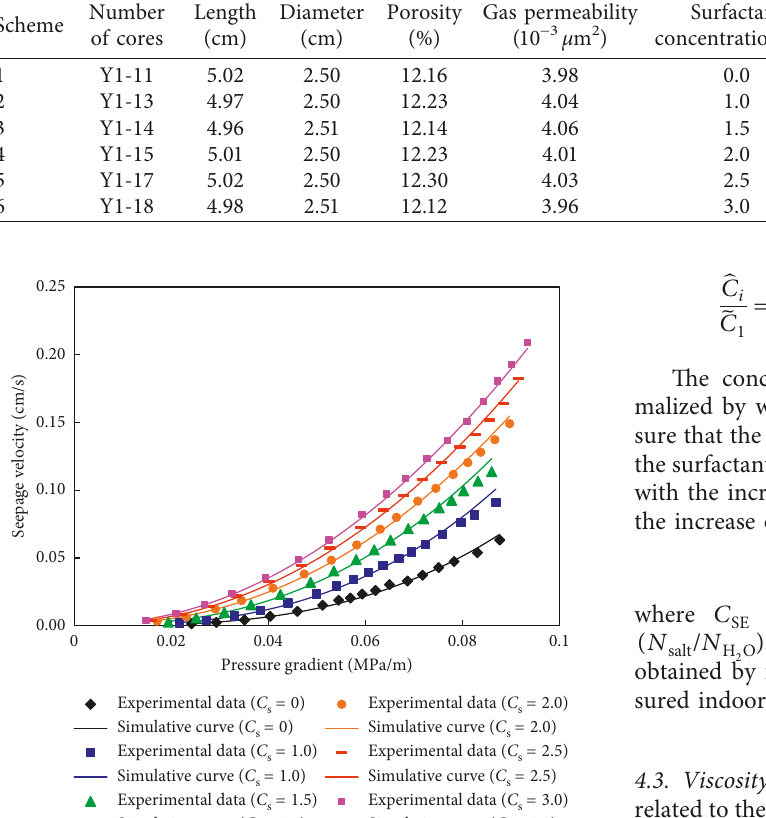
Experimental data ( C s = 0) Simulative curve ( C s = 0) Experimental data ( C s = 1.0) Simulative curve ( C s = 1.0) Experimental data ( C s = 1.5) Simulative curve ( C s = 1.5) Figure 1: Relationship curve between the seepage velocity and